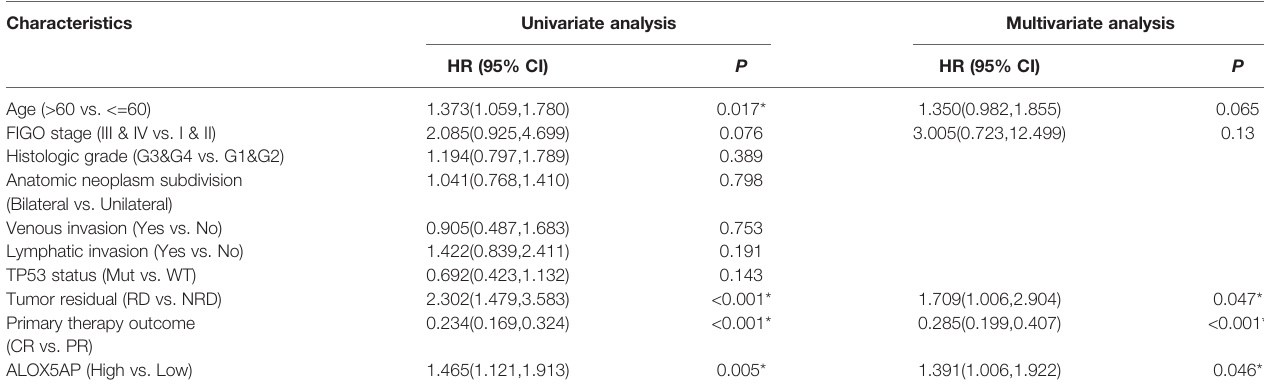
TABLE 1 | Univariate and multivariate Cox proportional hazards analysis of ALOX5AP expression and OS in TCGA-OV cohort.